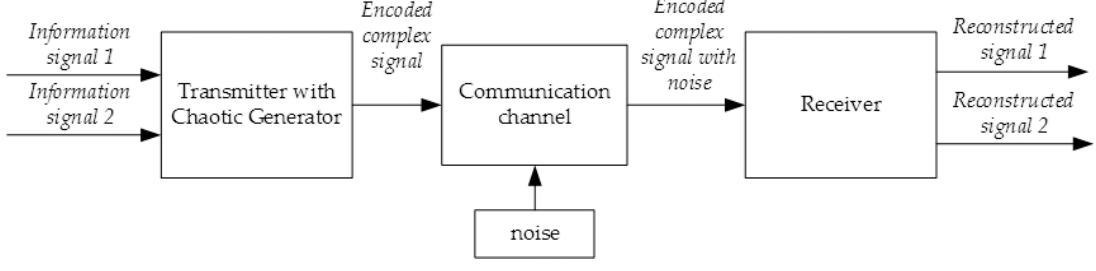
Figure 1. General block diagram of a chaotic communication system.